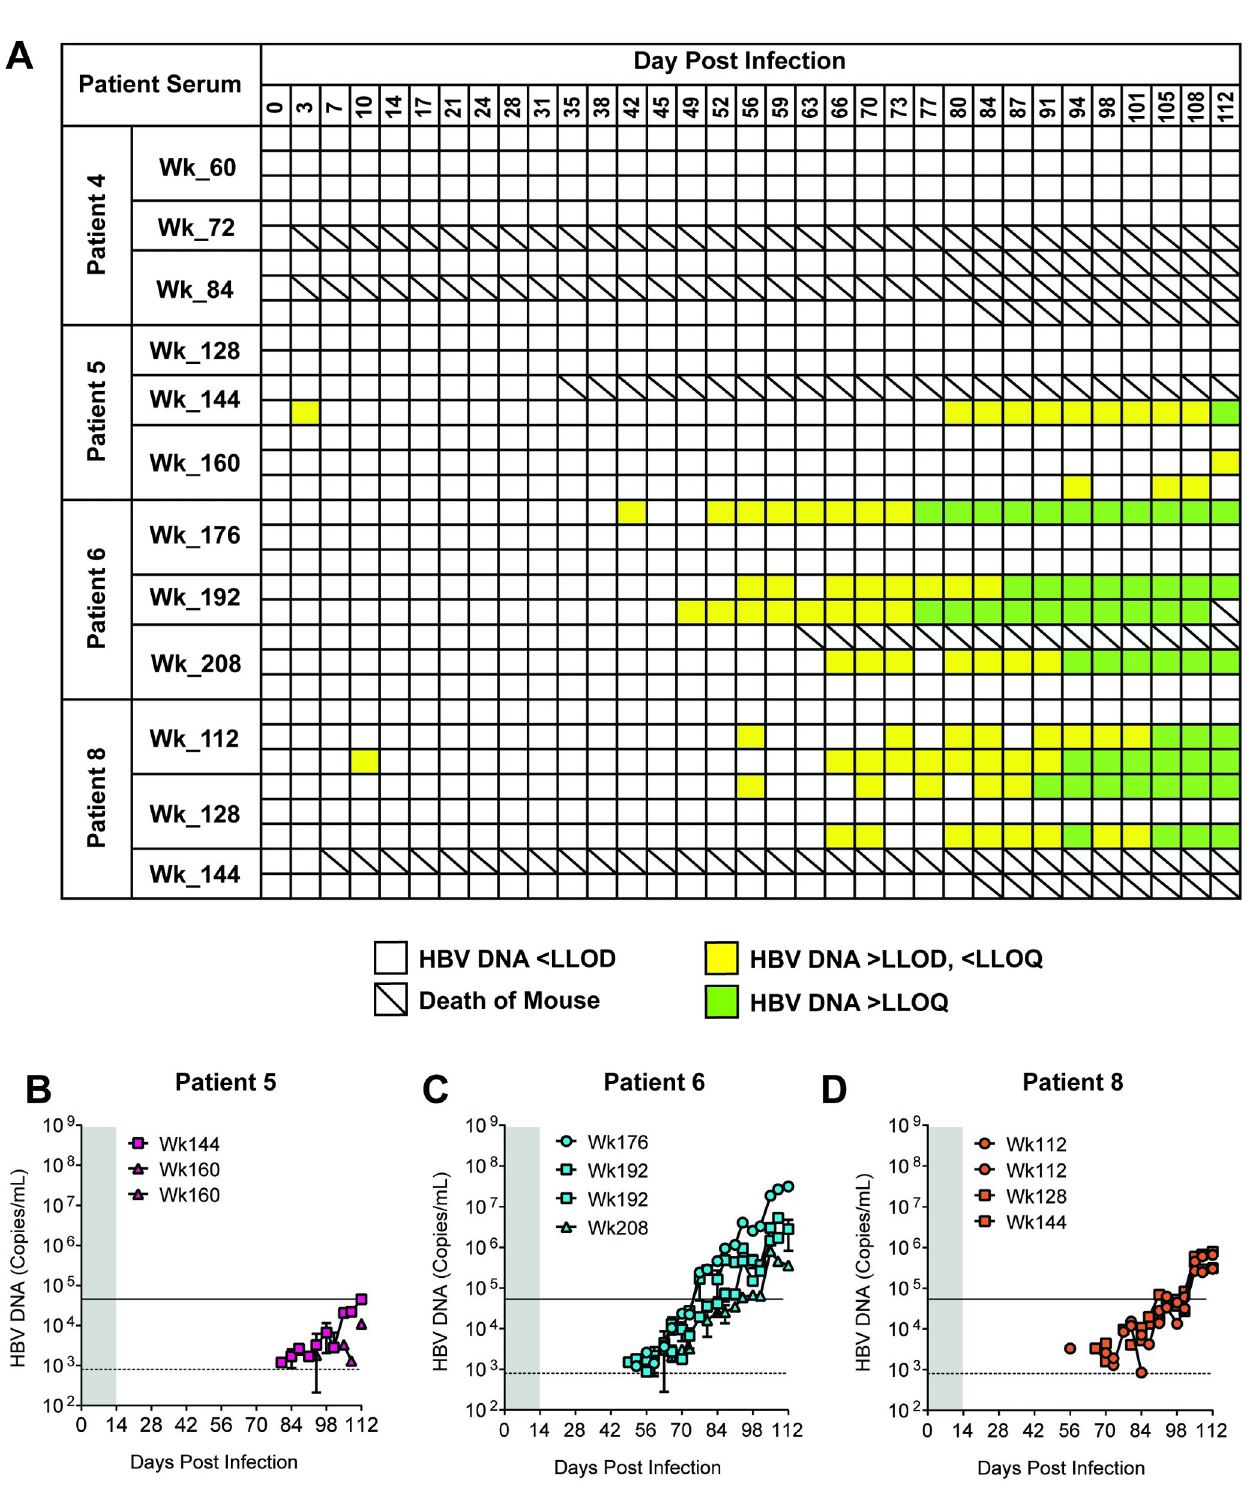
Fig 4. Patient serum samples below the LLOQ contain infectious virus. Human liver chimeric mice (n = 31) were inoculated with sera from CHB patients with HBV DNA levels < LLOQ but TD. a, Summary of PCR results over time. Blank squares indicate HBV DNA values were < LLOD. Yellow squares indicate HBV DNA values were > LLOD but < LLOQ. Green squares indicate HBV DNA values were > LLOQ. b-d, Infectivity of sera from NA-treated patients suppressed to below the LLOQ. HBV DNA was measured by qRT-PCR and reported as copies/mL. The dashed line represents the LLOQ (4 x 10 4 copies/mL) and the solid line represents the LLOD (8 x 10 2 copies/mL). Shaded gray area represents the two-week period over which mice were administered a total of 5 consecutive serum inoculations.